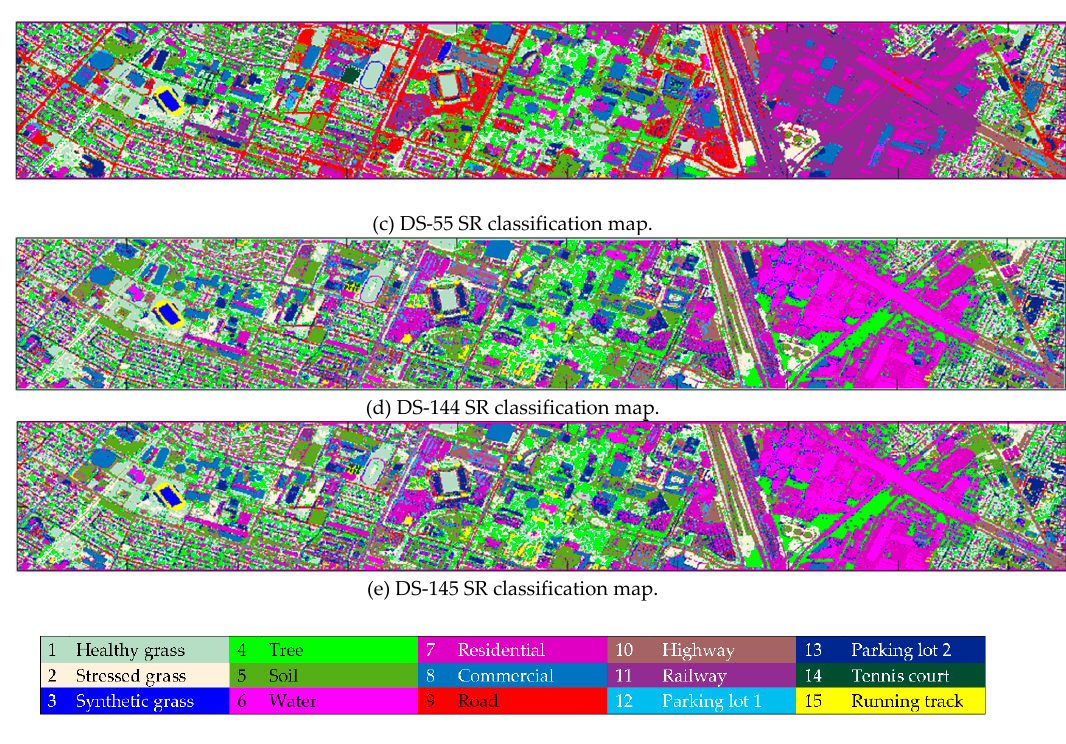
Figure A7. SR classification maps.